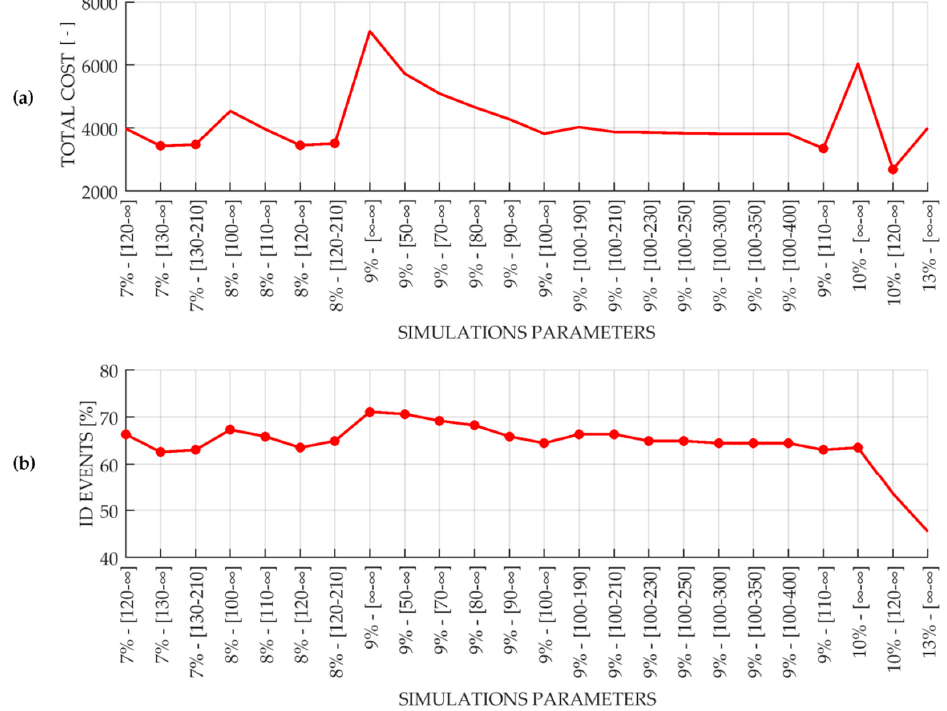
Figure 8. A comparison between the results obtained for a 24-h aggregation interval: Both the total cost ( a ) and the percentage of identified events ( b ) were derived using a false alarm cost equal to 1 and a missed alarm cost equal to 5. The horizontal axis was labelled with the parameters used in the simulations performed during the development of the new extreme rainfall detection methodology: the first value represents the percentage of the total rainfall while the values reported between the square brackets correspond to the lower and the upper boundaries. When no lower or upper boundaries were used, the ∞ symbol was reported. Better results (compared to the one obtained using the threshold methodology adopted in the previous version of ERDS) are highlighted with a red